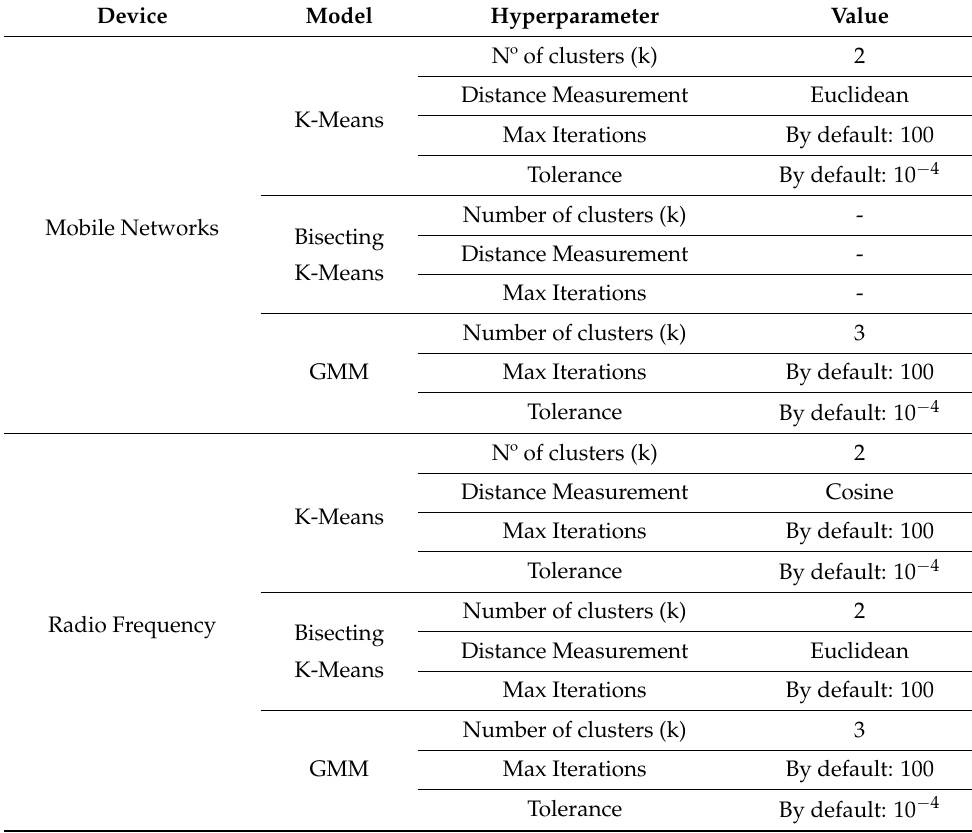
Table 2. Results of hyperparameters from each data